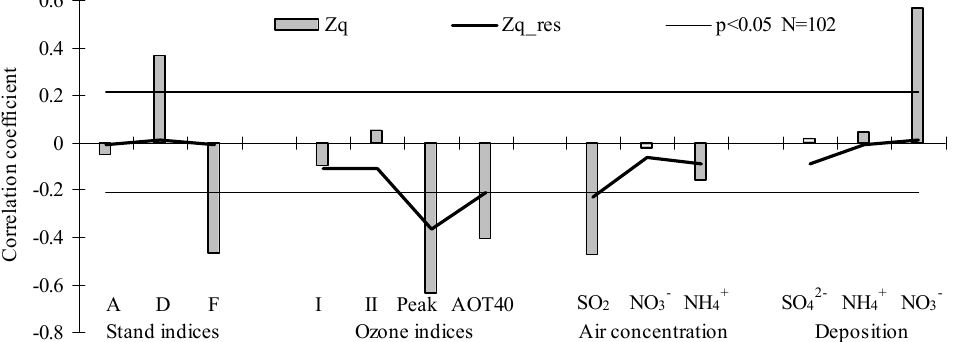
FIGURE 2. Relationships between basal area (Zq), and its residuals (Zq_res) with considered parameters of stand and pollution (I, mean value of O 3 for April–August; II, annual mean value of O 3